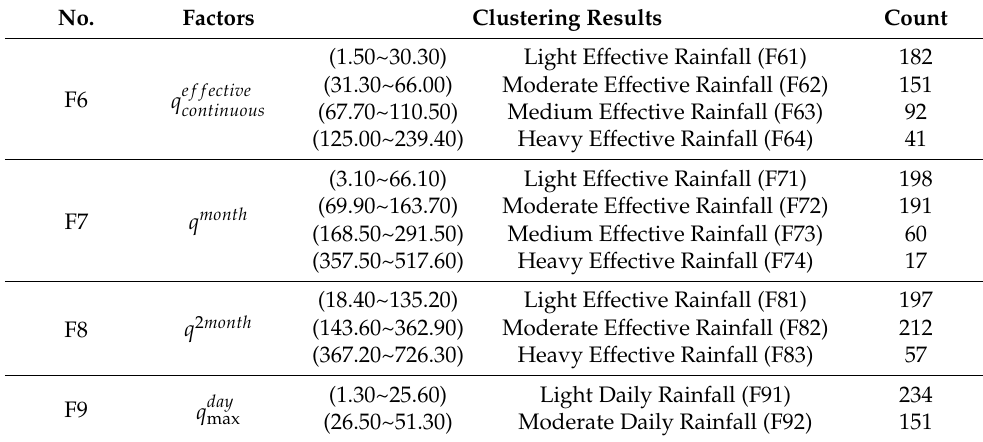
Table 3. Clustering results of the rainfall factors (ZG93, ZG118, XD01).